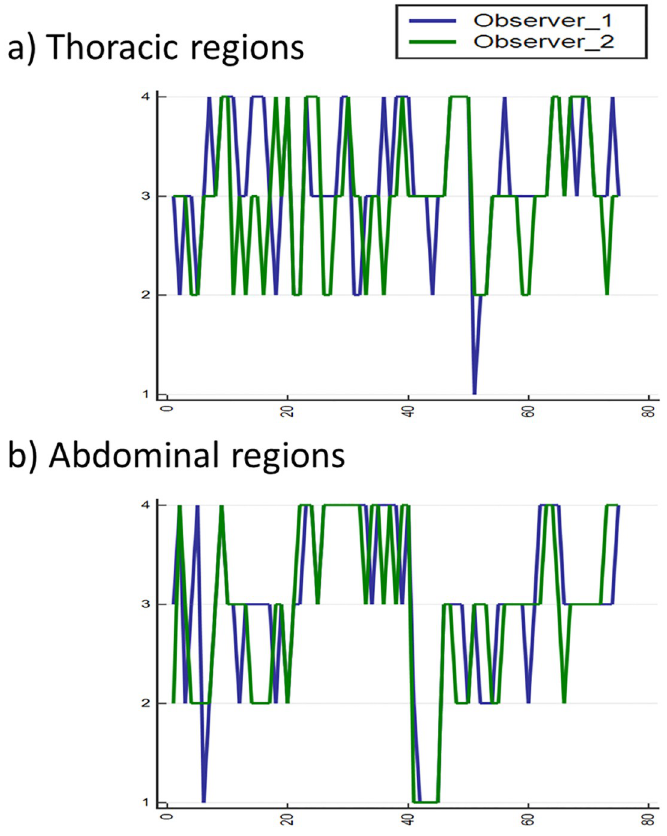
Fig 11. Scoring results for 30 patients (150 slices) evaluated by two operators performing manual sorting of 4DCT. a) Thoracic regions of 15 patients (75 slices) b) Abdominal regions of 15 patients (75 slices).